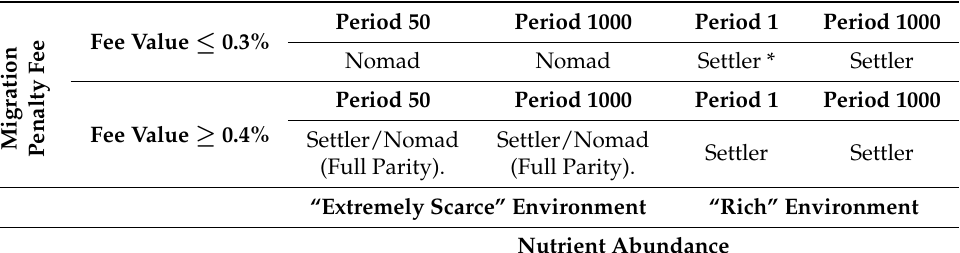
Table 5. Pivot table of outcomes (who is dominant in the system) for various groups of parameter values. The results do not differ for either quadratic and linear mortality except for the cases marked with an asterisk (*) where under linear mortality the following outcome is observed: Settler/Nomad (full parity). Batch period is measured in